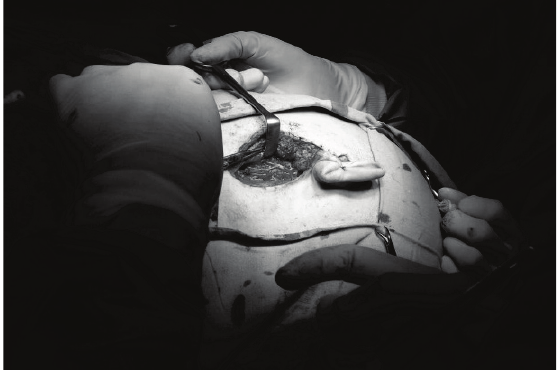
Figure 1. Total parotidectomy. Facial nerve visible beside the superficial lobe of the